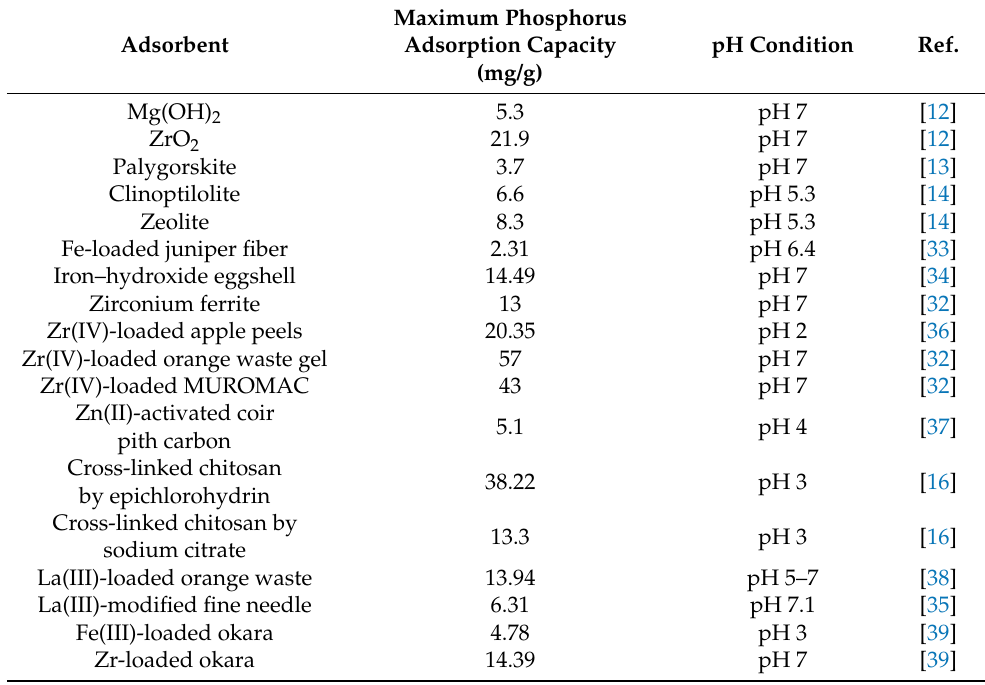
Table 4. Maximum phosphorus adsorption capacities of previously reported